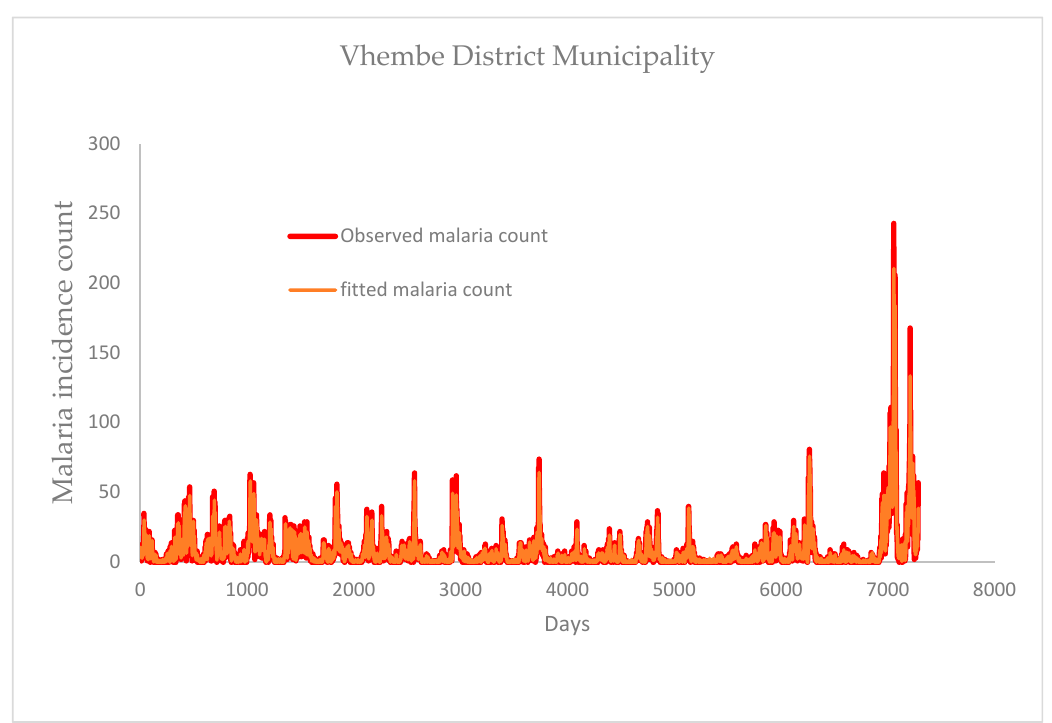
Figure 7. Comparison between fitted and observed malaria count for Mopani District.